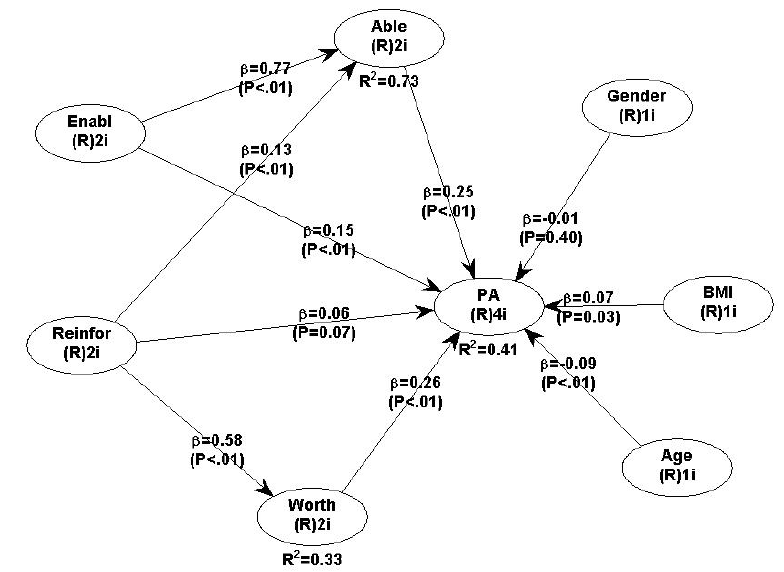
Figure 1. The structural model that explains PA, as proposed by [25]. Table 5. Estimated coefficients of the model with two mediators, explaining PA under the assumption of linear relation- ships.